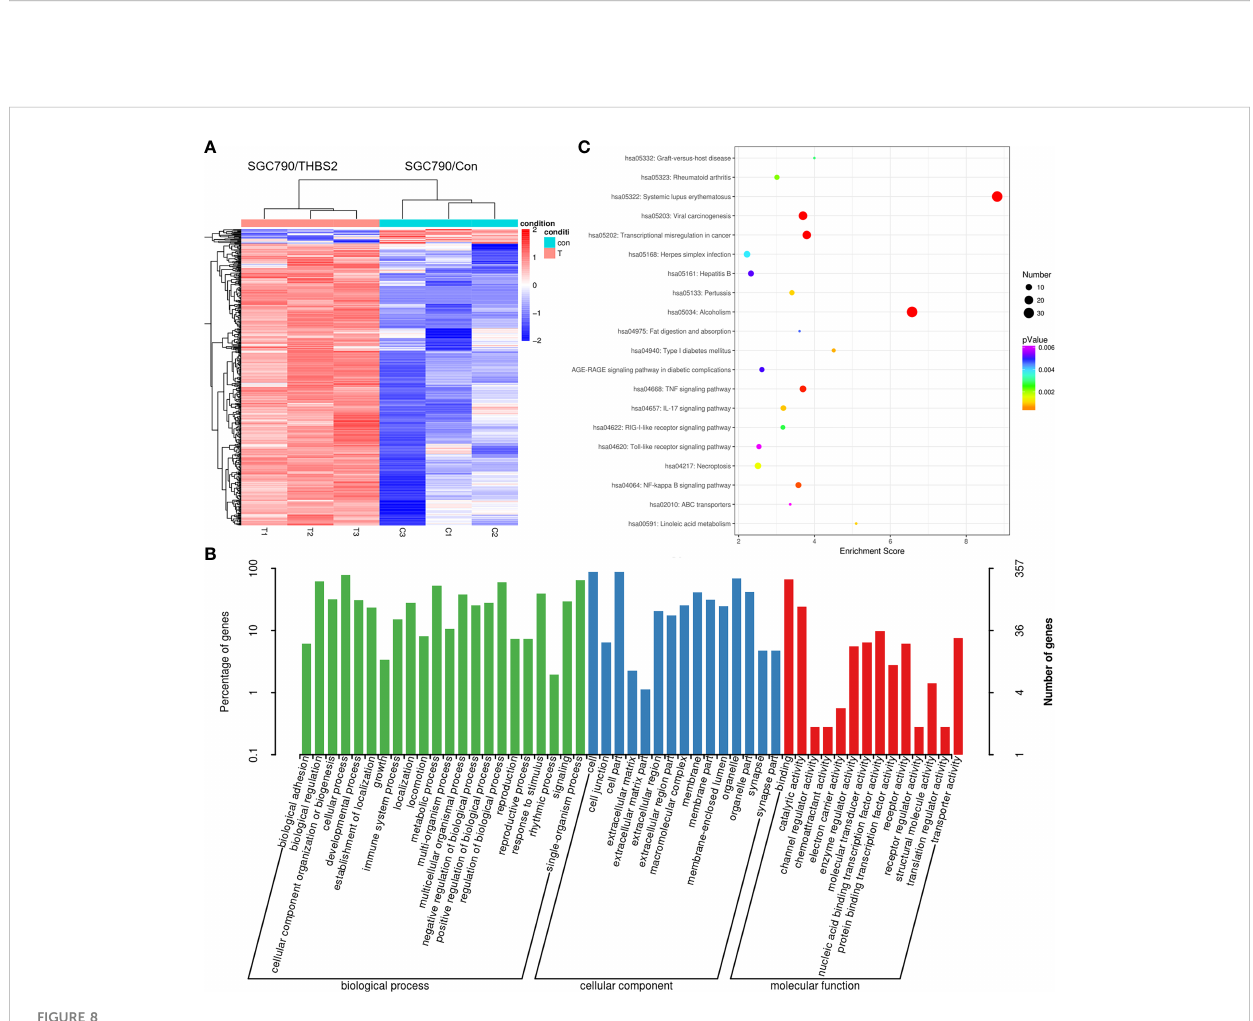
FIGURE 8 RNA-seq analysis of gene expression patterns in control and THBS2-overexpressing SGC-790 cells. (A) Dysregulated mRNAs are represented using a heatmap. (B) Top GO terms associated with mRNAs that were differentially expressed in SGC-790 cells overexpressing THBS2. (C) Top KEGG pathways associated with mRNAs that were differentially expressed in SGC-790 cells overexpressing